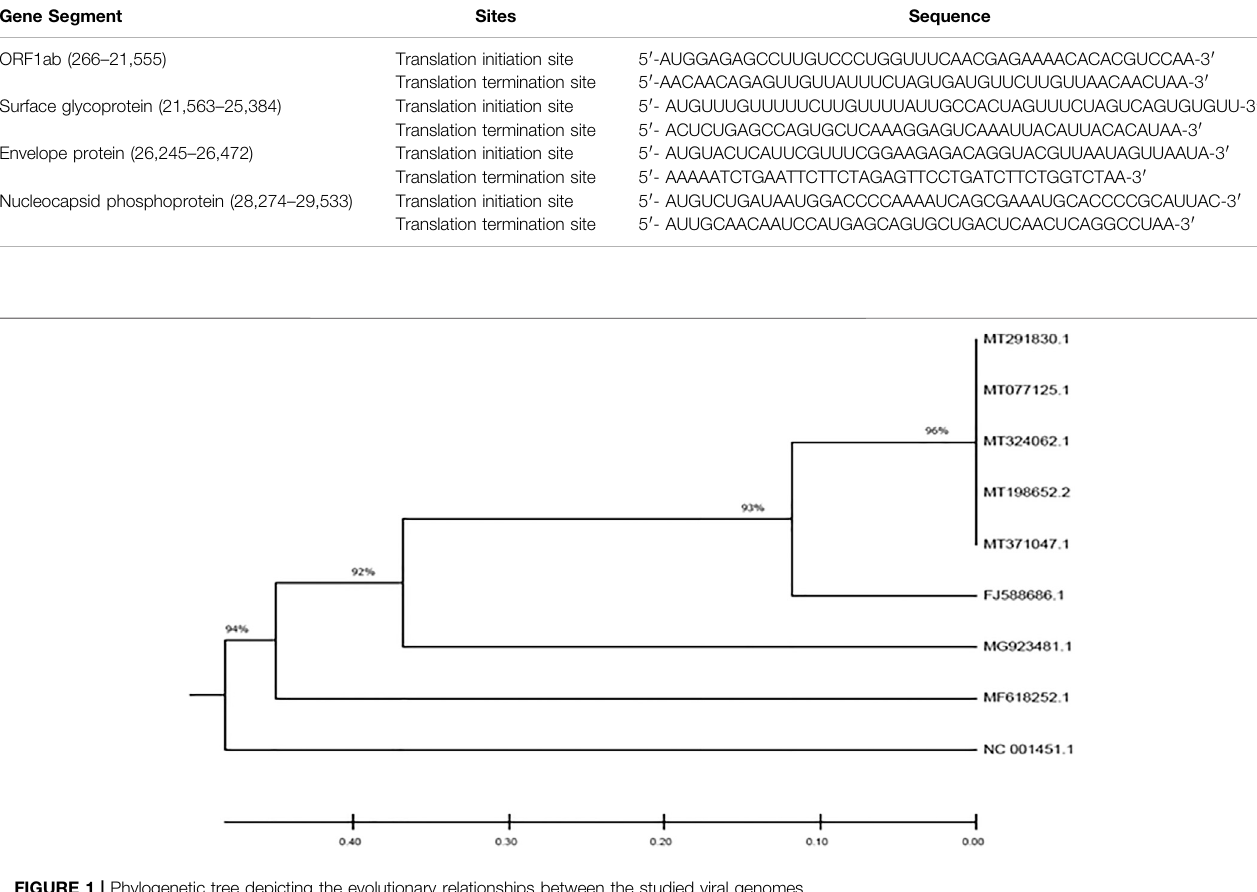
Frontiers in Pharmacology |